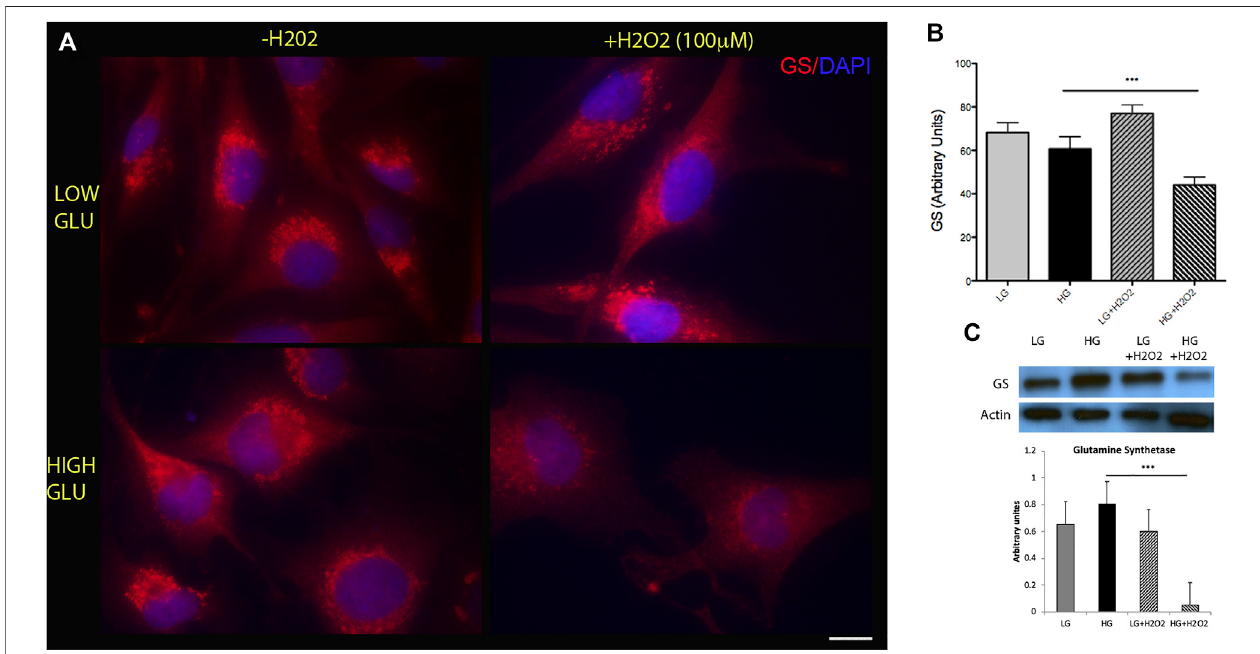
FIGURE 1 | High glucose and oxidative stress induce a decrease in glutamine synthetase (GS) levels. (A) Representative immuno fl uorescence showing GS levels (red) in MGs cultured under low glucose (LG, 5 mM) or high glucose (HG, 25 mM) concentrations with (+H 2 O 2 , 100 μ M) or without ( − H 2 O 2 ). DAPI was used for nuclei staining. Scale bar: 10 μ m. (B) Quanti fi cation was performed using the ImageJ program and differences were analyzed using the GraphPad Prism 5 software (One-way ANOVA followed by Bonferroni ’ s multiple comparison test). (C) Representative Western blot of GS levels. β -actin was used for normalization. Quanti fi cation of bands was performed using the ImageJ program. Images show a representative picture from three independent experiments. Data are mean ± SE, *** p < 0.001.